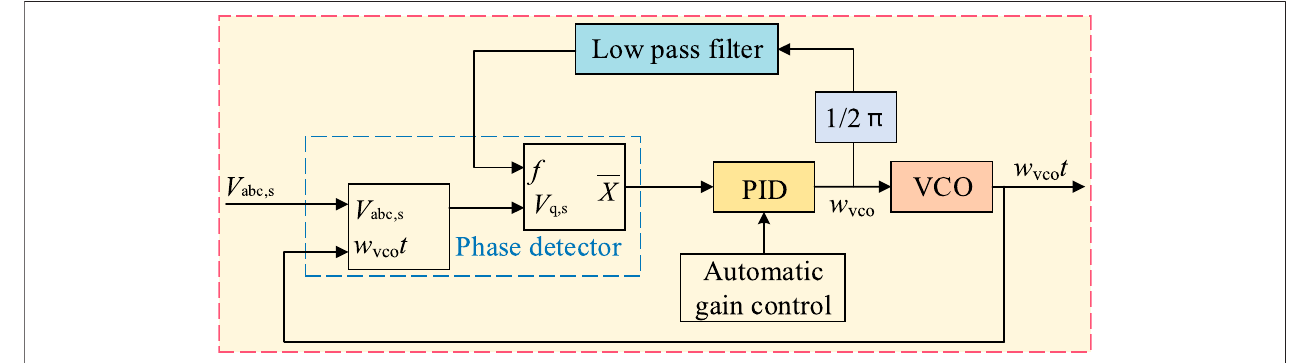
FIGURE 3 | The basic structure of three-phase